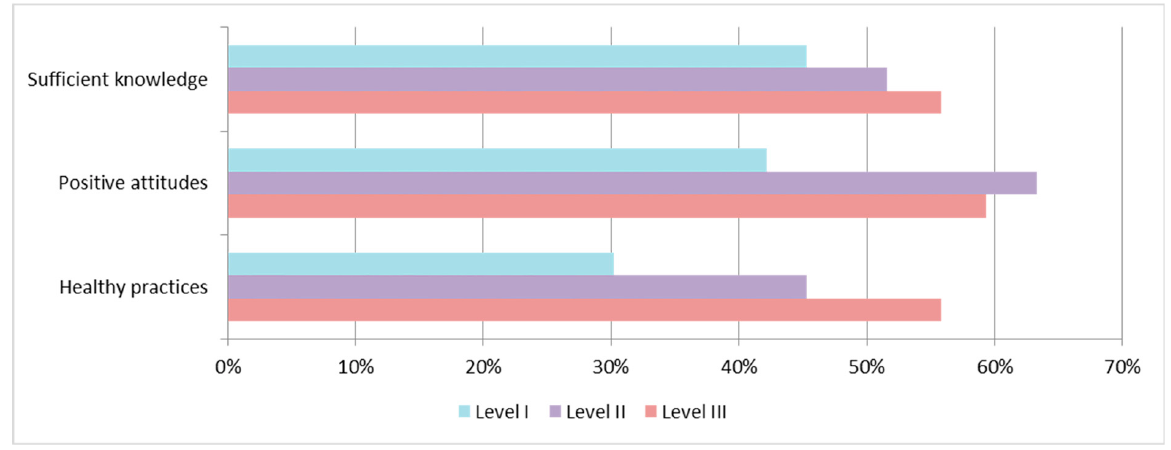
Figure 1. Knowledge, attitudes, and practices of COVID-19 in the three different lockdown levels. Level I, not restricted; level II, partially restricted; level III, restricted.